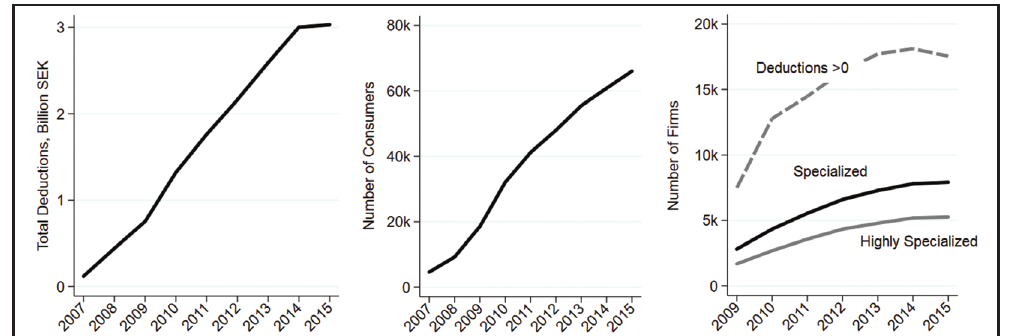
Figure 3 Total annual tax-deductions, number of consumers, and number of subsidized